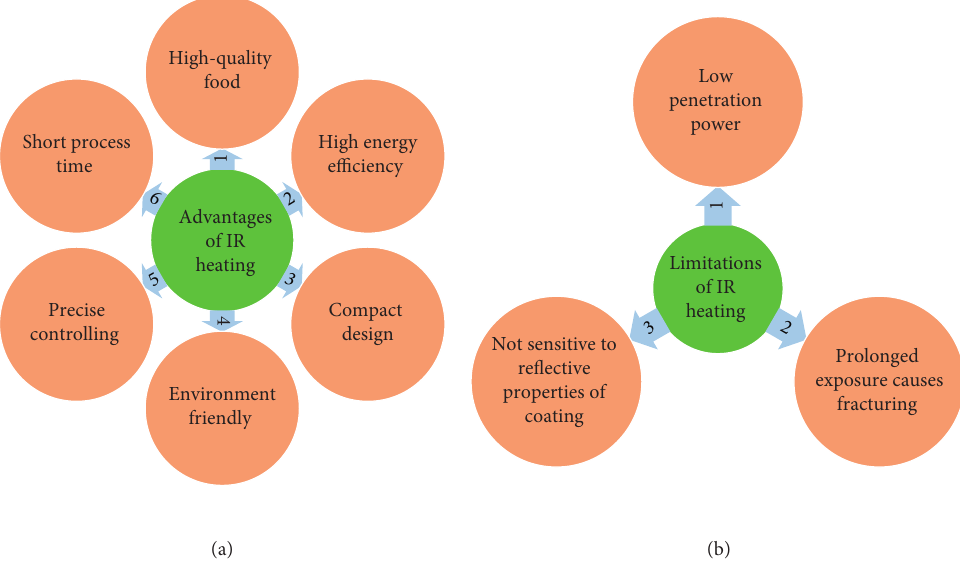
Figure 3: Some advantages and limitations of IR heating used for roasting nuts and other foods.